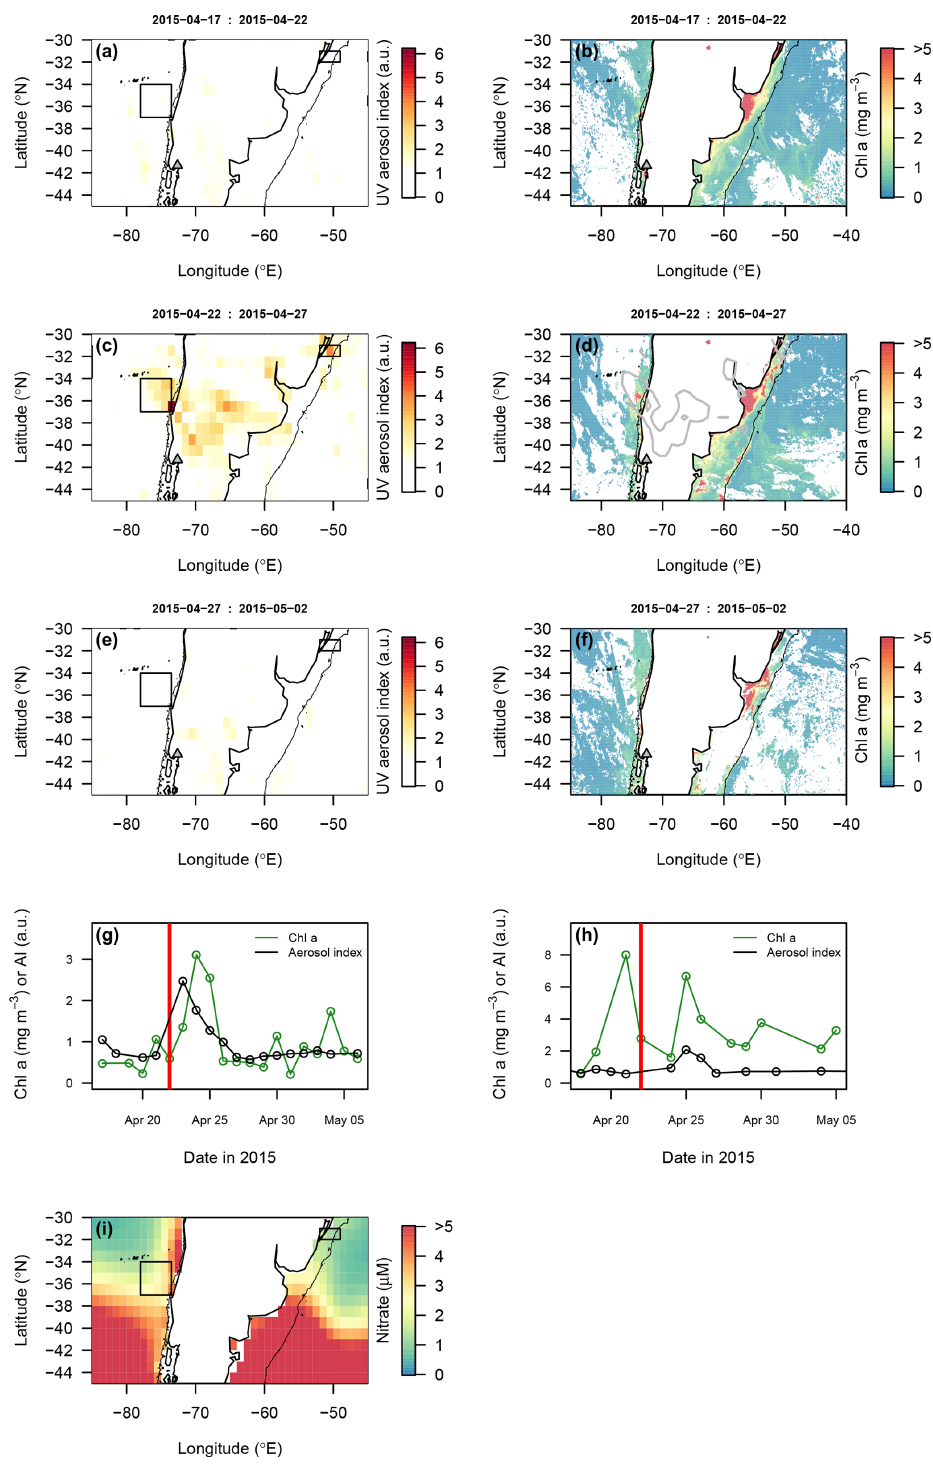
Figure 8. Potential biological impact of the 2015 Calbuco eruption observed via satellite remote sensing. (a–f) Spatial maps showing the distribution of ash in the atmosphere (UV aerosol index) and corresponding images of chlorophyll a . Images were composited over 5d periods. Grey lines in the chlorophyll maps correspond to the UV aerosol index = 2a.u. contour. (g, h) Time series of the UV aerosol index and chlorophyll a for regions of the Pacific (g) and Atlantic (h) oceans, identified by boxes in the maps. Red vertical lines (22 April) indicate the first eruption date. (i) Mean World Ocean Atlas surface NO 3 concentrations. Thin black lines indicate the 500m bathymetric depth